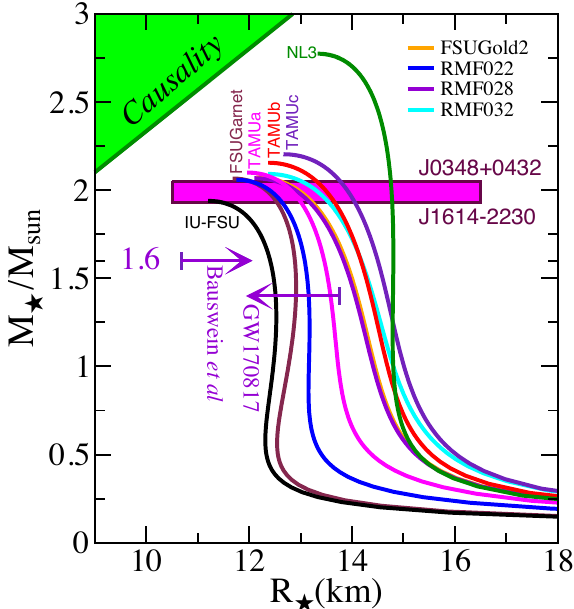
Figure 1. (Color on-line) Mass–radius relation of neutron stars (NSs) predicted for different relativistic mean-field (RMF) models identified in the legend. Shown also are the masses of two heavy NSs and the constraints following from the tidal deformability of the GW event. Figure taken from [11] with